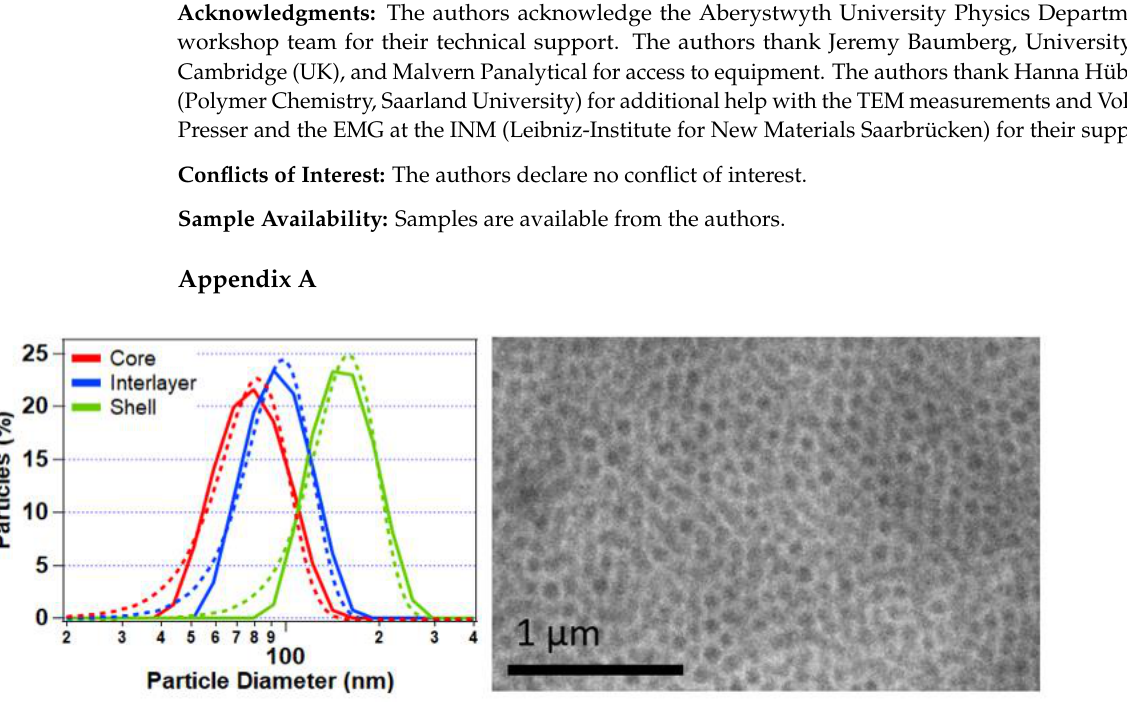
Figure A1. DLS data ( left ) showing the distribution of the nanoparticles following growth of the core, interlayer, and shell, with the Gaussian fits denoted by the dashed lines of the respective color. The y -axis denotes the percentage of the total number of particles of each size contributing to the total scattering intensity. A reproducibly low polydispersity index (PDI) of approximately 0.006 was obtained for the final CIS particles, of a diameter of 151 nm. This was calculated by Malvern Zetasizer proprietary software as 𝑃𝐷𝐼 = (𝑠𝑡𝑎𝑛𝑑𝑎𝑟𝑑 𝑑𝑒𝑣𝑖𝑎𝑡𝑖𝑜𝑛 𝑚𝑒𝑎𝑛⁄ ) 2 [37]. TEM of a 40 BIOS opal after microtoming showing random hexagonal close packing (right). Figure A2. Fast Fourier transform (FFT) analysis (inset) of the SEM, as shown in Figure 1c of the 5 BIOS film. Examination of the corresponding radial distribution in the left panel shows a single predominant nonzero spatial frequency, with a peak intensity at approximately 6 μm −1 , correspond- ing to a real-space periodicity of approximately 165 nm in good agreement with the DLS character- ization of the particle size (and, thus, the 111-plane packing distance). The nature of this packing was additionally elucidated in terms of a 2D spatial autocorrelation function (right), showing a dis- tinctive six-point symmetry indicative of hexagonal close packing. References 1. Yablonovitch, E. Inhibited spontaneous emission in solid-state physics and electronics. Phys. Rev. Lett. 1987 , 58 , 2059. 2. John, S. Strong localization of photons in certain disordered dielectric superlattices. Phys. Rev. Lett. 1987 , 58 , 2486. 3. Yablonovitch, E.; Gmitter, T. Photonic band structure: The face-centered-cubic case. Phys. Rev. Lett. 1989 , 63 , 1950. 4. Zhang, Z.; Satpathy, S. Electromagnetic wave propagation in periodic structures: Bloch wave solution of Maxwell’s equations. Phys. Rev. Lett. 1990 , 65 , 2650. 5. Ho, K.; Chan, C.T.; Soukoulis, C.M. Existence of a photonic gap in periodic dielectric structures. Phys. Rev. Lett. 1990 , 65 , 3152. 6. Joannopoulos, J.D.; Villeneuve, P.R.; Fan, S. Photonic crystals: Putting a new twist on light. Nature 1997 , 386 , 143 – 149. 7. Yoshioka, S.; Kinoshita, S. Single-scale spectroscopy of structurally colored butterflies: Measurements of quantified reflectance and transmittance. J. Opt. Soc. Am. A 2006 , 23 , 134 – 141. https://doi.org/10.1364/JOSAA.23.000134. 8. Kinoshita, S.; Yoshioka, S.; Fujii, Y.; Okamoto, N. Photophysics of structural color in the Morpho butterflies. Forma 2002 , 17 , 103 – 121.